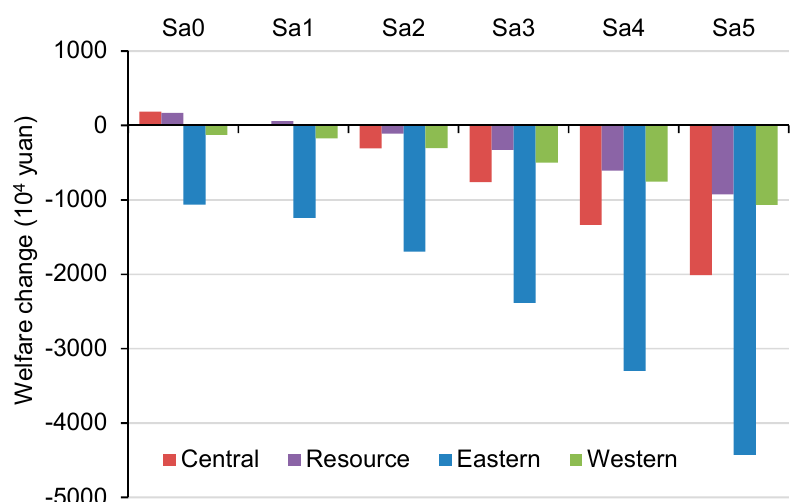
Figure 9. Regional welfare changes under different scenarios.